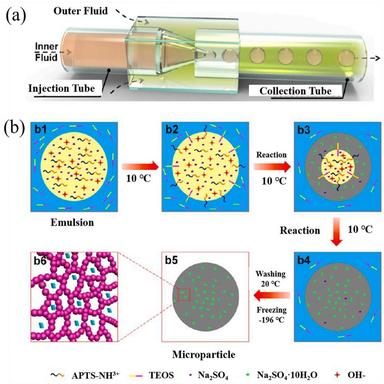
Schematic illustration of microfluidic fabrication of Na2SO4⋅10H2O@SiO2 microparticles from W/O emulsions. (a) Microfluidic device for generating W/O emulsion templates. (b) Formation of Na2SO4⋅10H2O@SiO2 microparticles via hydrolysis and condensation (b1 − b4) and freezing (b5) for constructing SiO2 matrix and crystallizing Na2SO4 into Na2SO4⋅10H2O (b6) . Reproduced with the permission of the American Chemical Society.